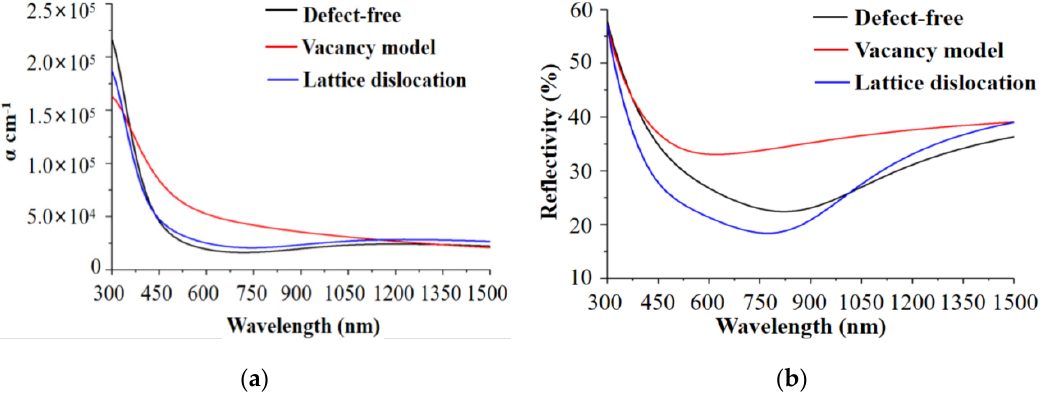
Figure 4. ( a ) Absorption coefficients and ( b ) reflectivity of the defect models at 300–1500 nm.